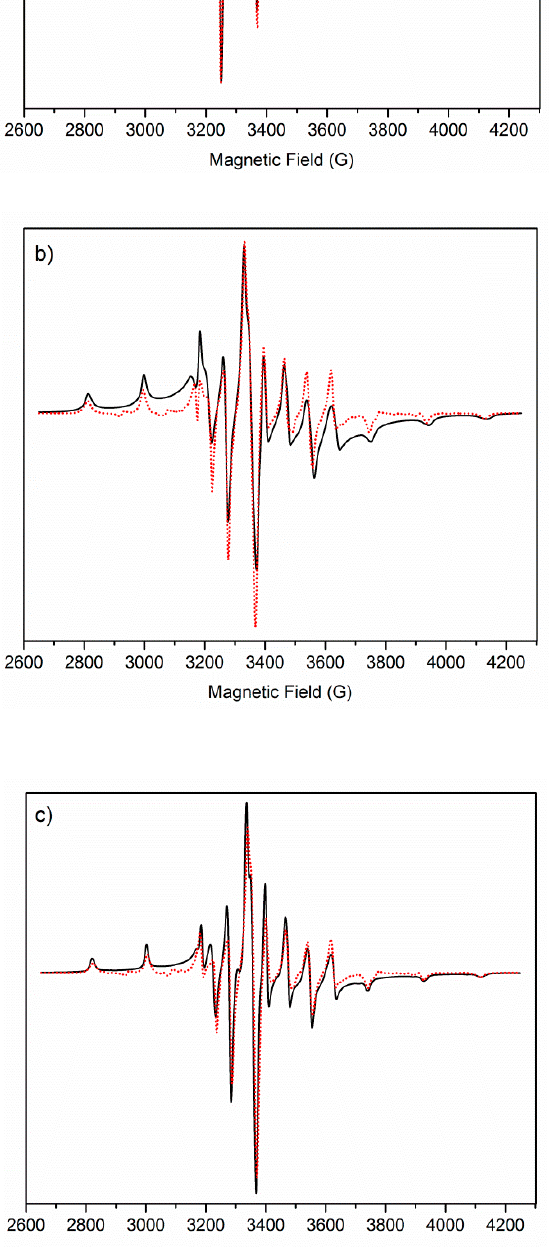
Figure 6. LT EPR spectra. Experimental (black solid line) and computed (red dot line) frozen solution EPR spectra of ( a ) VO 2+ pentaaquo ion, ( b ) VO–SC at pH 5.6, and ( c ) VO–SC at pH 8.